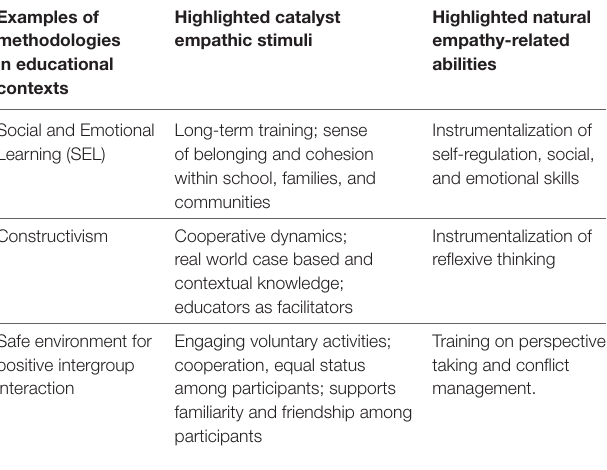
TABLe 2 | Highlighted educational approaches for empathy-related learning through environmental stimuli and enhancement of specific empathy-related